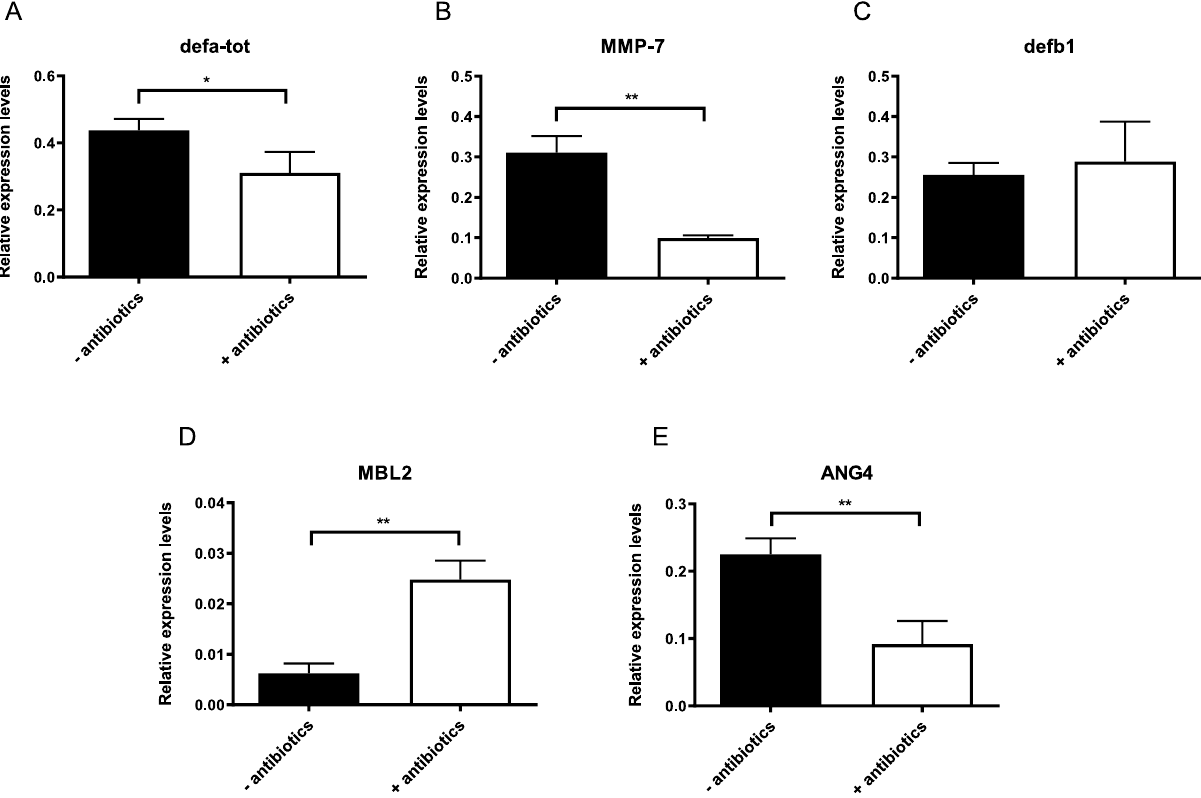
Figure 3. Effect of antibiotic treatment on the transcription of anti-microbial peptides and MBL2 in non- infected control mice without (black bar) and with (white bar) after 5 days of antibiotic cocktail treatment ( A ) α-defensins (defa-tot), ( B ) MMP-7, ( C ) defb1, ( D ) MBL2 and ( E ) ANG4. Relative mRNA expression levels were measured by qPCR. Mean transcription level from 5 mice are shown with SEM as error bars. (*p ≤ 0.05, **p ≤